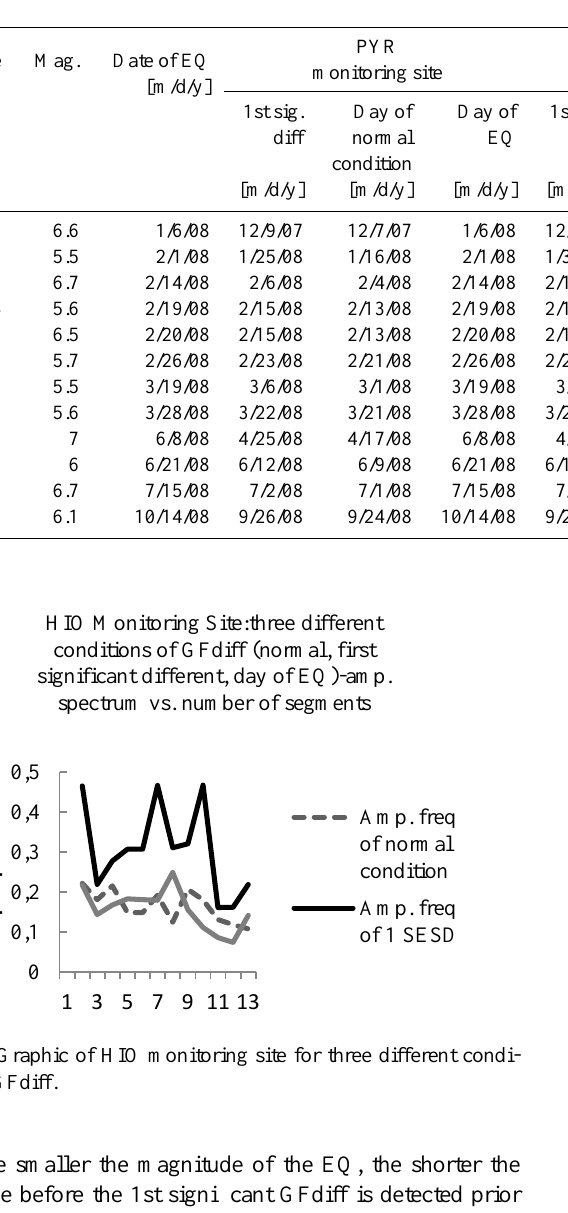
Table 2. List of EQs registered in Greece in 2008.